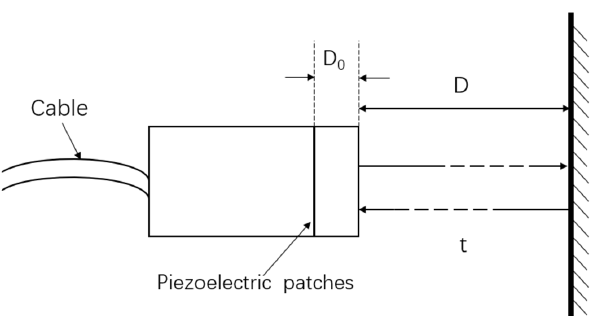
Figure 3. Schematic of the error calculation from the ultrasonic transducer to the borehole wall.